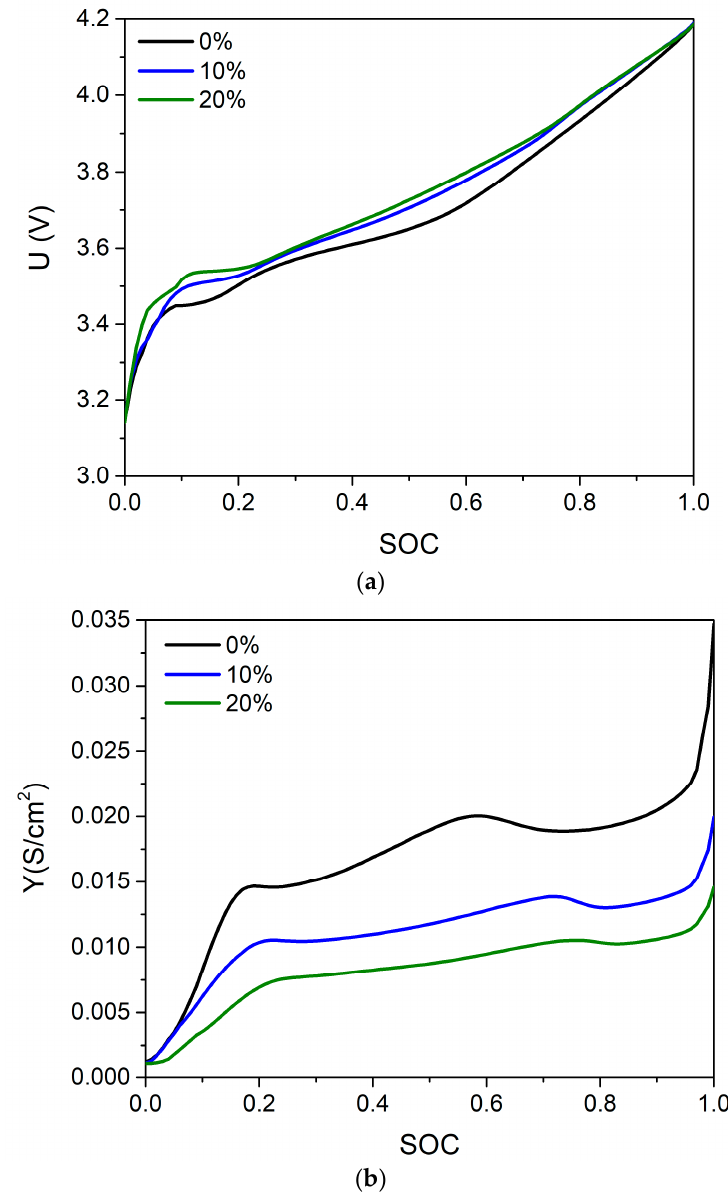
Figure 4. ( a ) U as a function of state of charge (SOC); and ( b ) Y as a function of SOC for the LIB cells with three different levels of the loss of cyclable lithium of 0%, 10%, and 20%. With the object of the model validation, the calculated discharge curves from the model using U